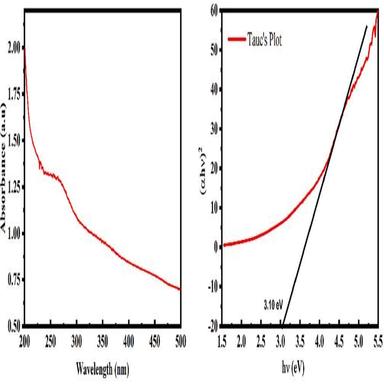
V–vis spectra of green synthesised ZnO nanoparticles (left) and corresponding Tauc's plot (right).